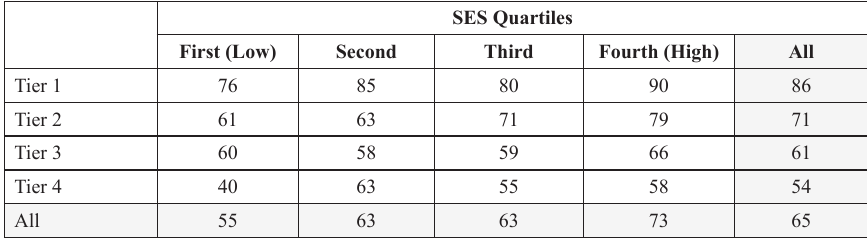
Table 2. Comparison of collegiate 6-year graduation rates (percentage) by a